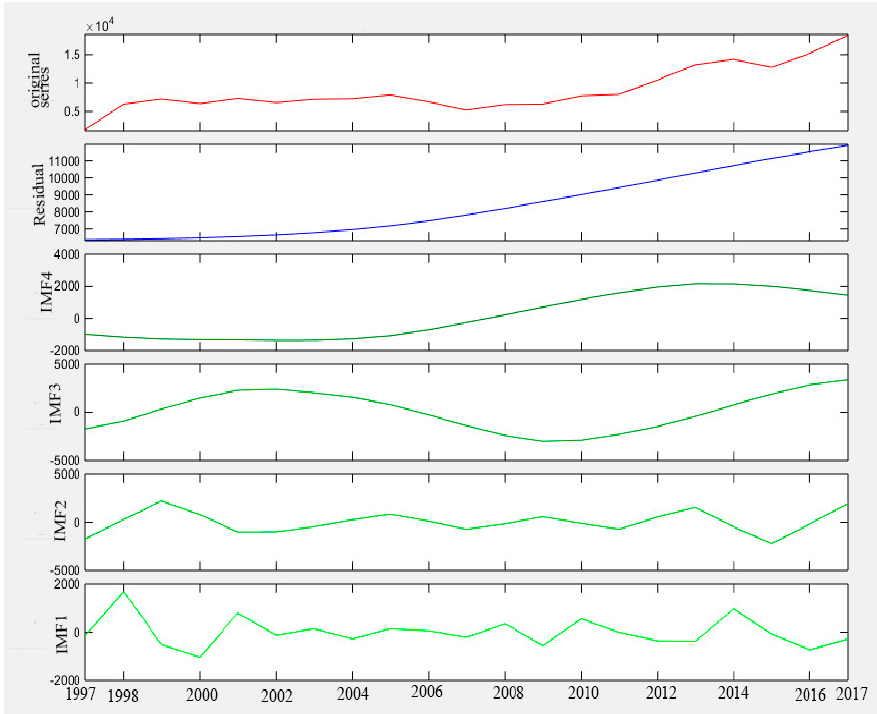
Figure 4. Decomposition results of renewable energy terminal power consumption.